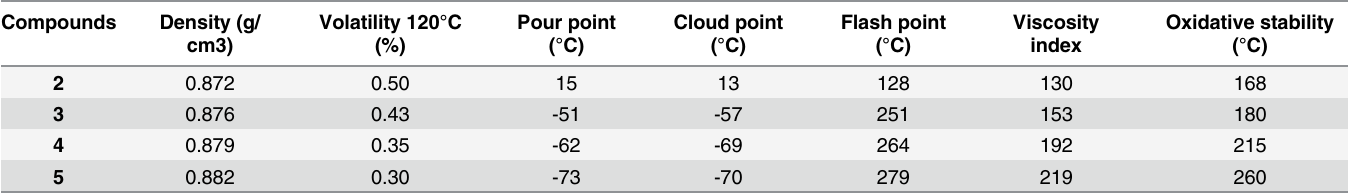
Table 4. Physicochemical characteristics of synthesis